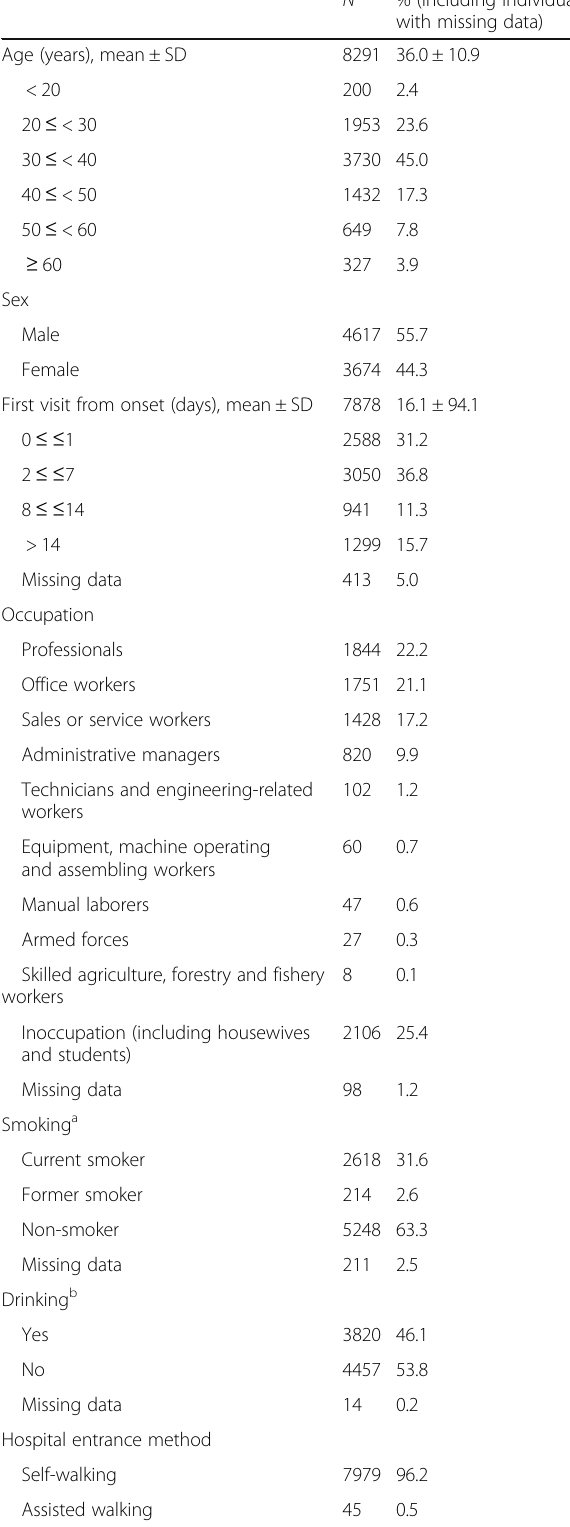
Table 1 Sociodemographic characteristics, medical comorbidities, and prior treatment for current symptoms